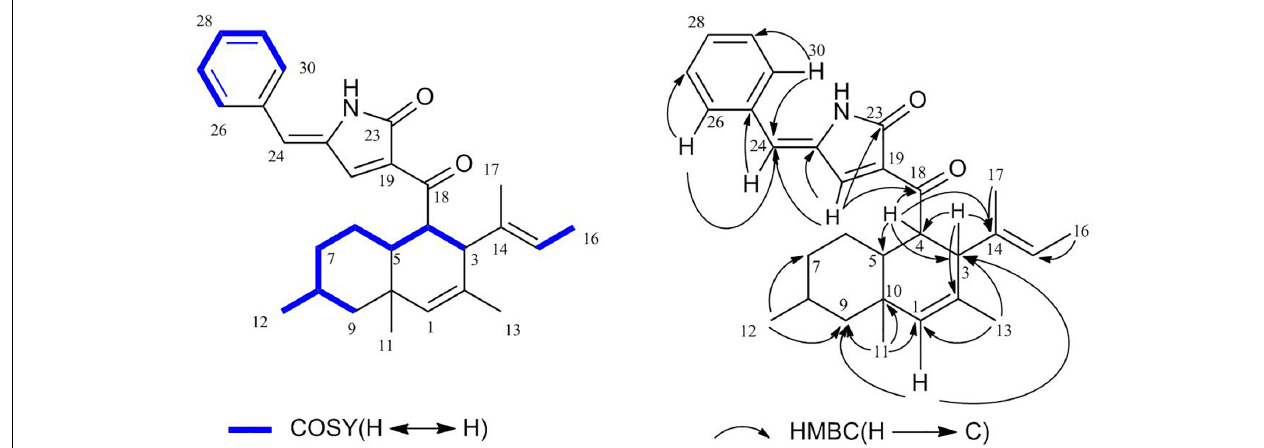
FIGURE 3 | 1 H– 1 H COSY and Key HMBC correlations of 1 .